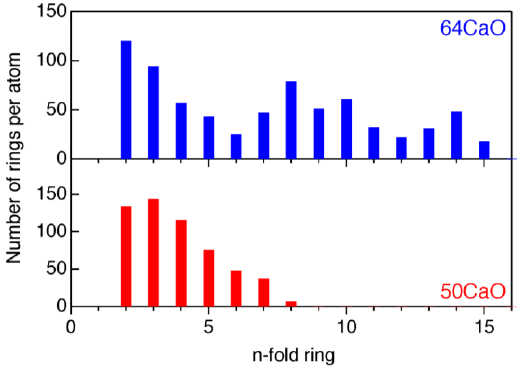
Figure 7. Distribution of –Al(Ca)–O–Al(Ca)–O–Al(Ca)– rings in 50CaO and 64CaO glasses for reverse Monte Carlo (RMC)-DFT models